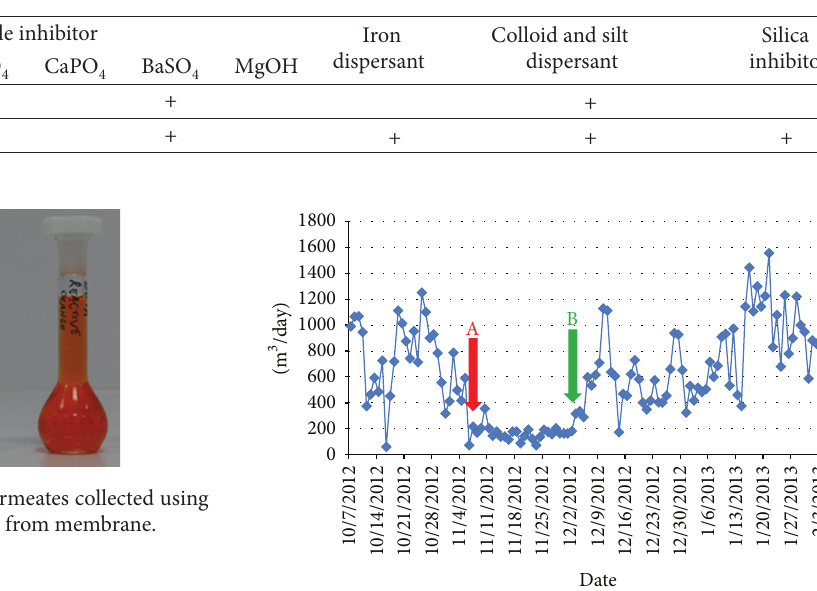
Table 4: Information of antiscalants.